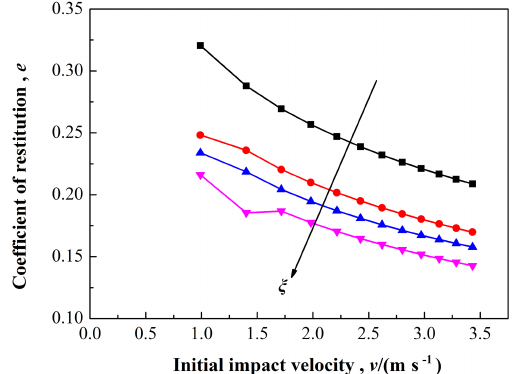
Figure 17. The contact force as a function of contact deflection for H = 20cm, and with ξ varied from 1 / 8 to 7 /